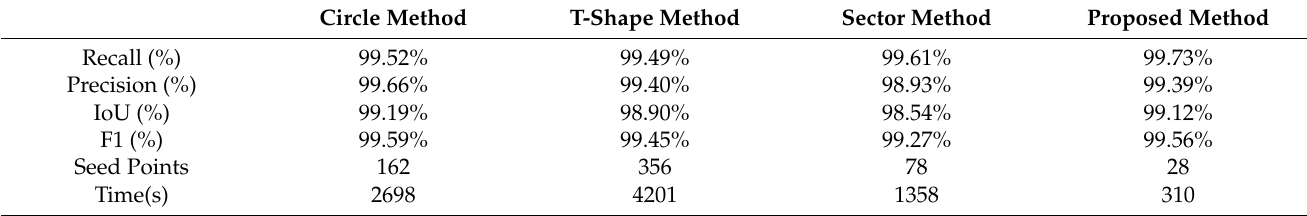
Table 3. Comparison information of different